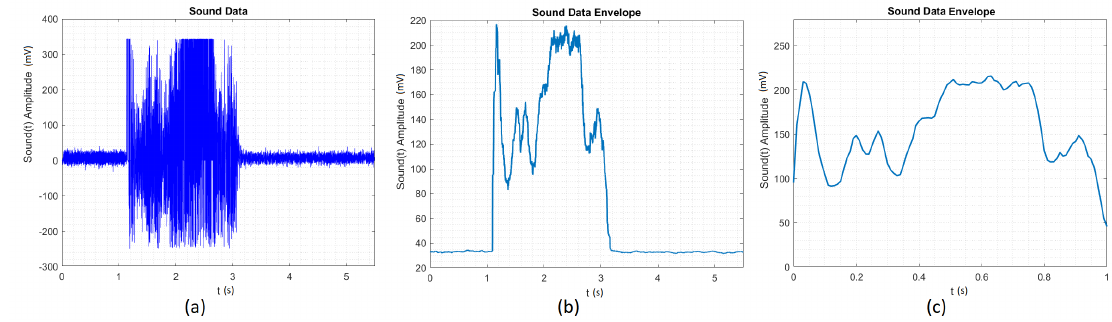
Figure 7. ( a ) Time signal for Circle. ( b ) Time envelope signal for Circle. ( c ) Time scaled envelope signal for